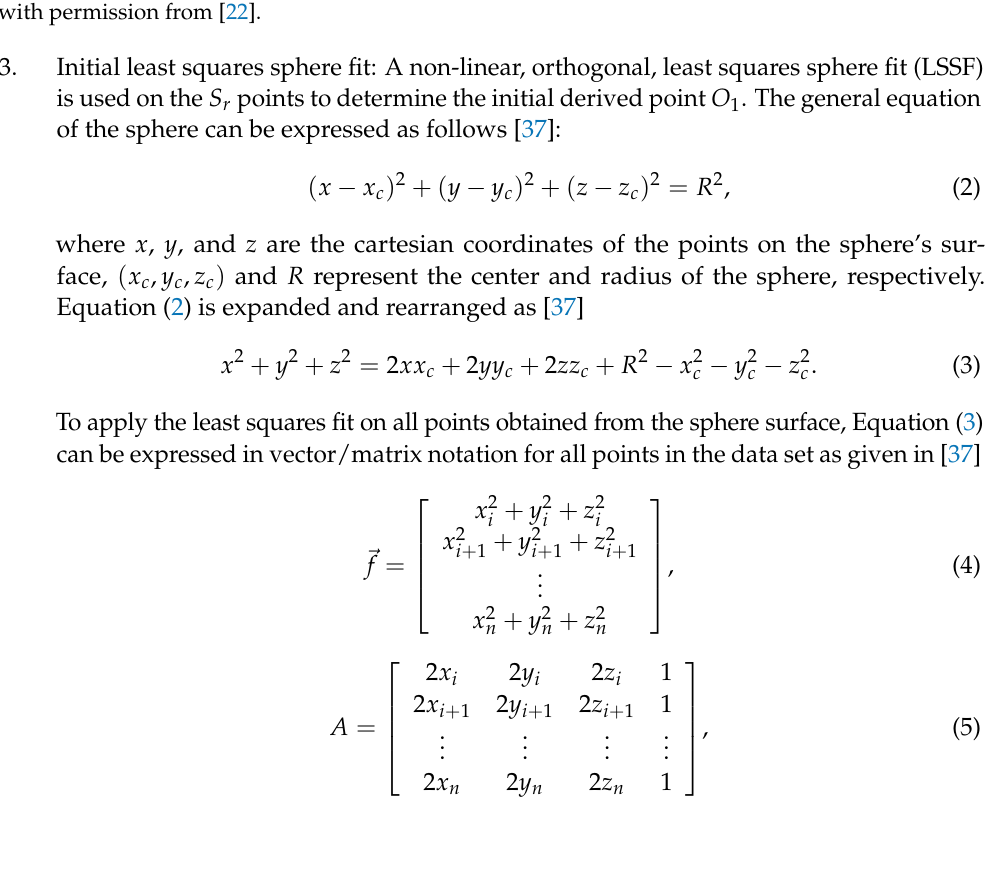
Figure 14. Closest point method. ( a ) r 1 is the median of the M smallest distances of points from the DUT origin. ( b ) r 2 = r 1 + R , where R denotes the radius of the sphere target, source: reproduced 2 with permission from